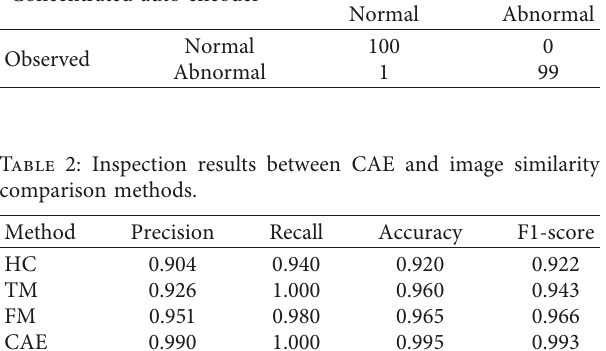
Table 1: Confusion matrix of the CAE method. Concentrated auto encoder